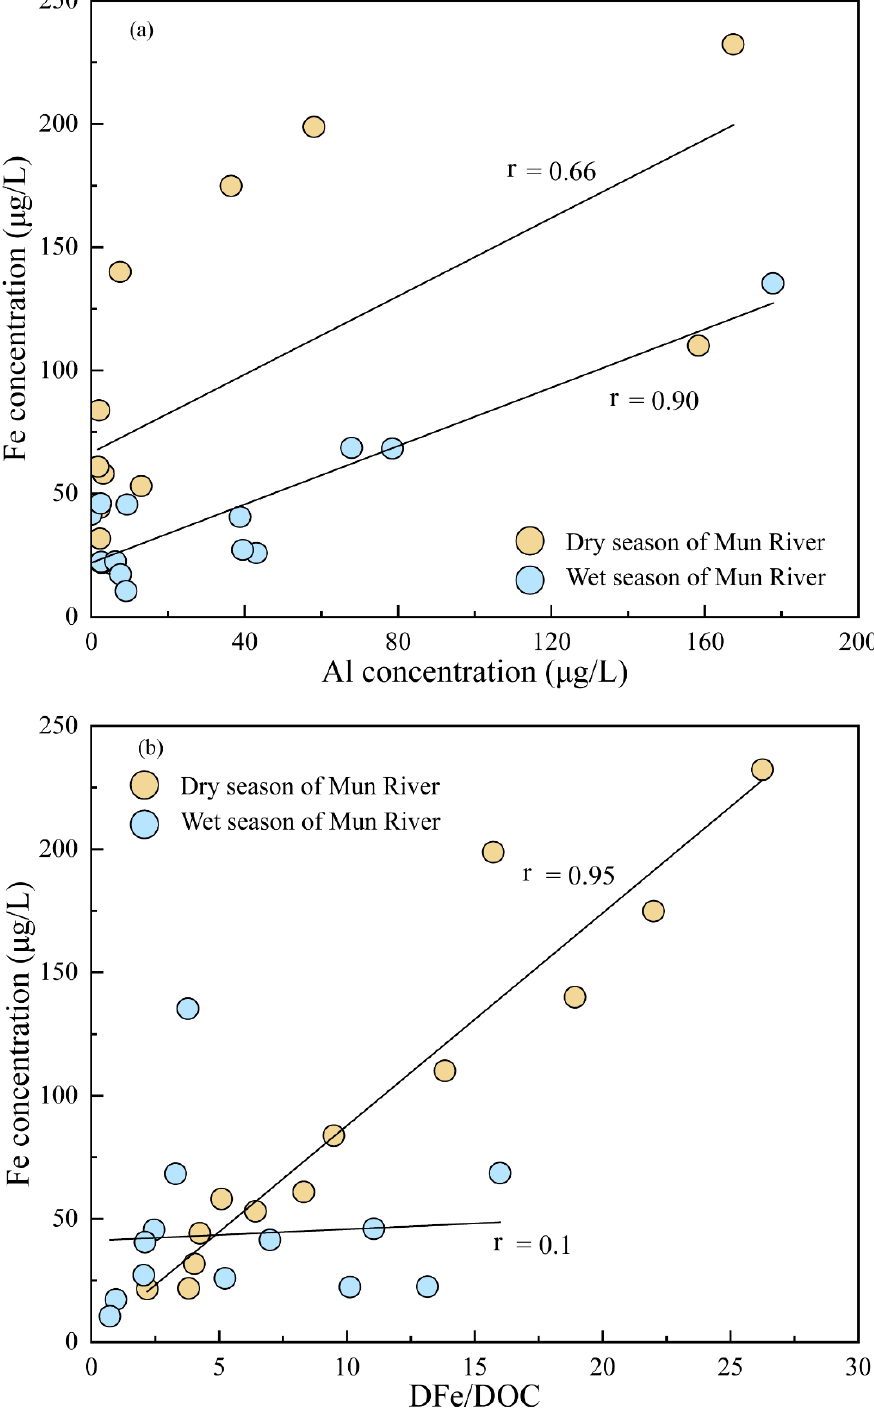
Figure 4. Fe concentrations ( µ g/L) versus ( a ) Al concentrations ( µ g/L) and ( b ) DFe/DOC ratio in MR water.